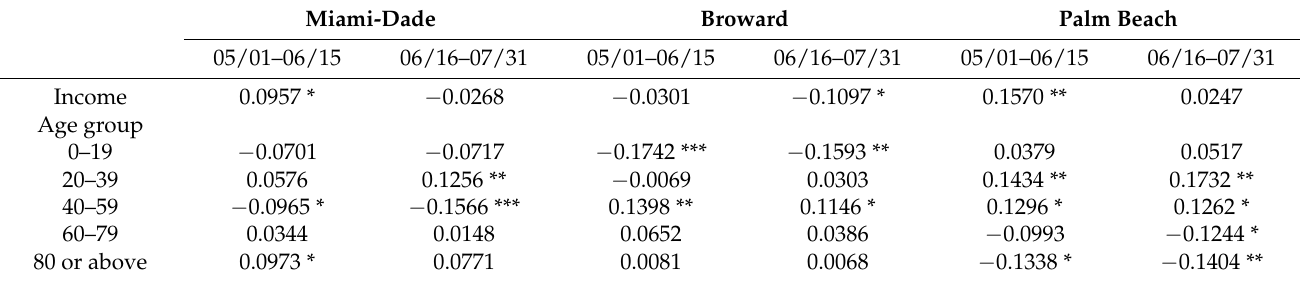
Table 5. Pearson correlation analyses between inflow trips per person and median household income and age groups for Miami-Dade, Broward, and Palm Beach counties for 05/01–06/15/2020 and 06/16–07/31/2020. Miami-Dade Broward Palm Beach 05/01–06/15 06/16–07/31 05/01–06/15